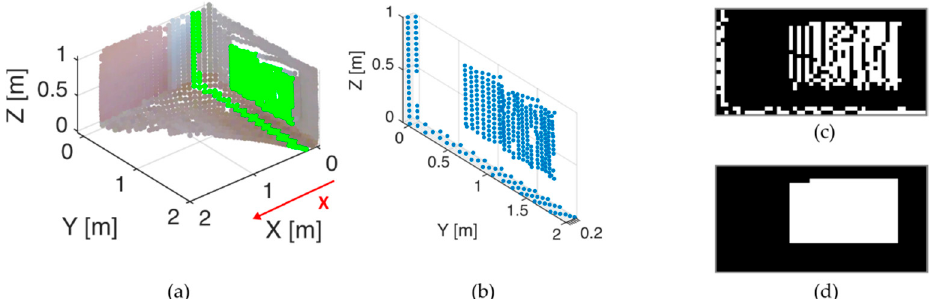
Figure 10. Planar surface detection in X-axis: ( a ) 2 nd level selection in the X-axis; ( b ) Segmented point cloud; ( c ) Resulting level image; ( d ) Morphologically closed and opened image.